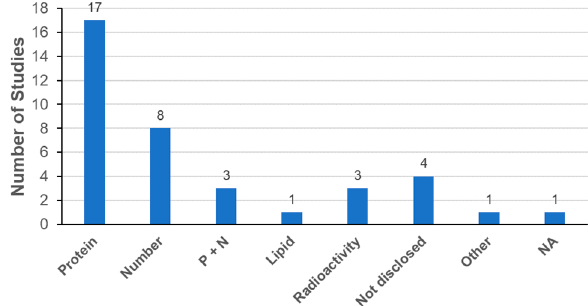
Figure 7. Determination of exosome dose in biodistribution. Abbreviations: Protein, total amount of proteins; number, total number of particles; P + N, total amount of proteins with total number of particles; Lipid, total amount of lipids .